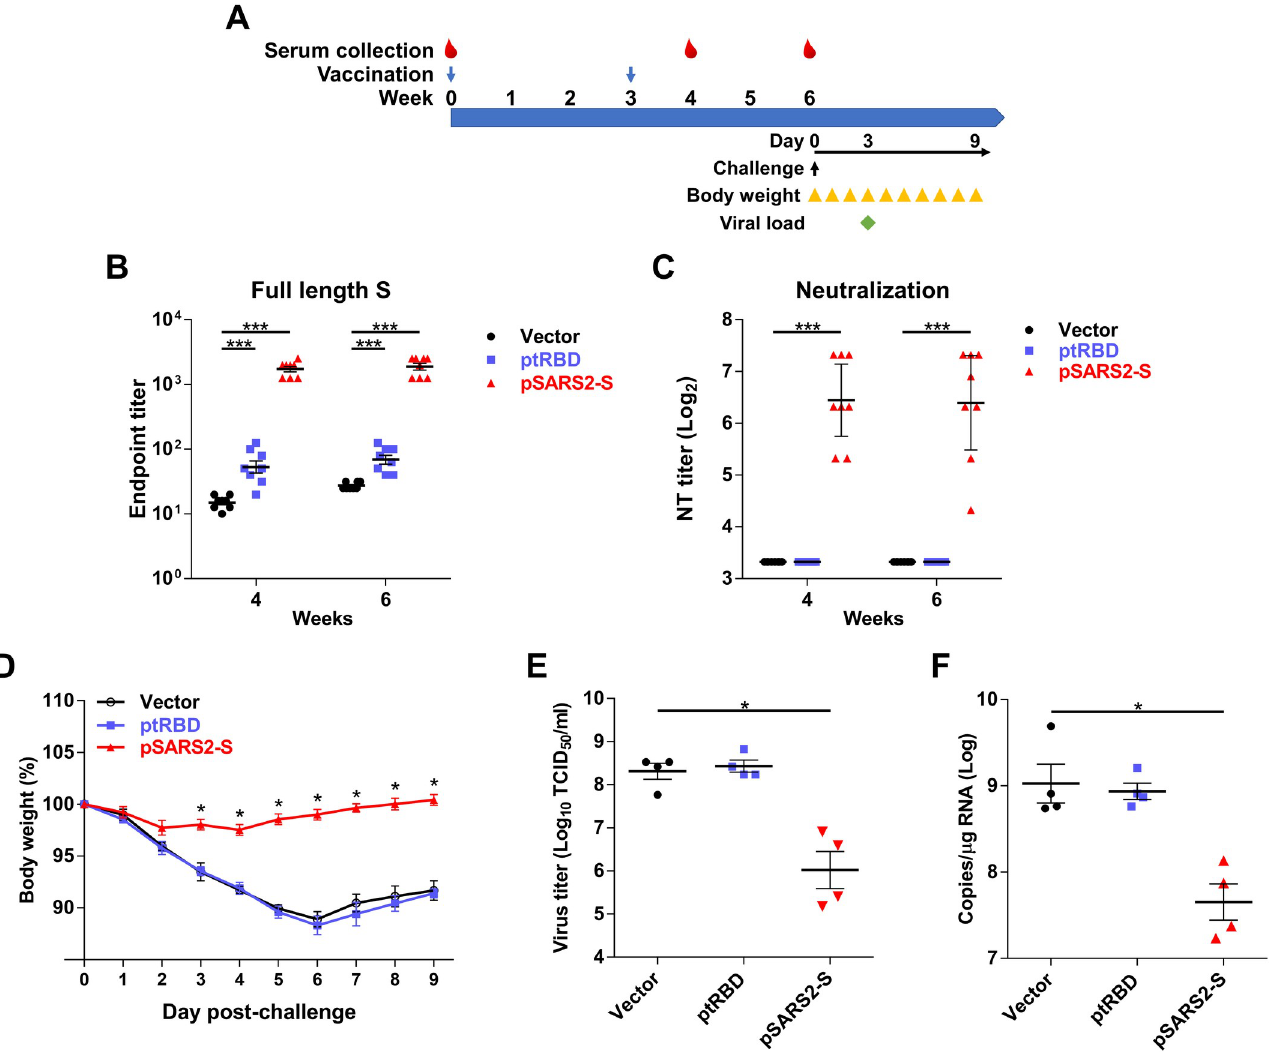
Fig 6. Prophylactic efficacy of SARS-CoV-2 S DNA vaccine in SARS-CoV-2-infected hamsters. (A) Time course of DNA vaccination and SARS-CoV-2 challenge. Syrian hamsters were intramuscularly immunized twice at a 3-week interval with 100 μ g of control, pSARS-S or pSARS2-S, followed by electroporation. Serum samples were collected by retroorbital blood sampling at weeks 4 and 6 after the first immunization. At 4 weeks after the second immunization, Syrian hamsters were intranasally challenged with 10 5 TCID 50 SARS-CoV-2. (B) Antibodies against the SARS-CoV-2 full-length spike protein were evaluated by ELISA. (C) Vaccine-induced neutralizing activity against SARS-CoV-2 was evaluated by neutralization assay. (D) Body weight change (%) of the hamsters was recorded every day after SARS-CoV-2 challenge. Virus titers (E) and viral RNA copies (F) in the lungs of SARS-CoV-2-infected hamsters at 3 days postchallenge were determined by TCID 50 assay and qRT-PCR, respectively. Antibody titers are presented as the mean ± SEM, and neutralization titers are expressed as the geometric mean with a 95% confidence interval. � p < 0.05, ��� p < 0.001 by the Mann-Whitney